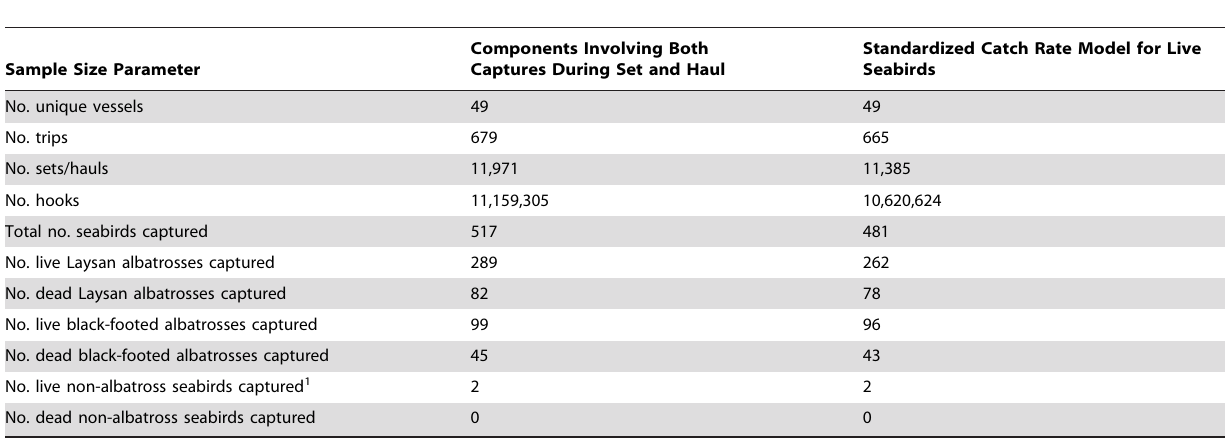
Table 1. Summary of sample sizes for (a) study components considering both seabird captures during setting and hauling, and (b) a standardized catch model for live seabirds, which considered seabird captures during hauling.